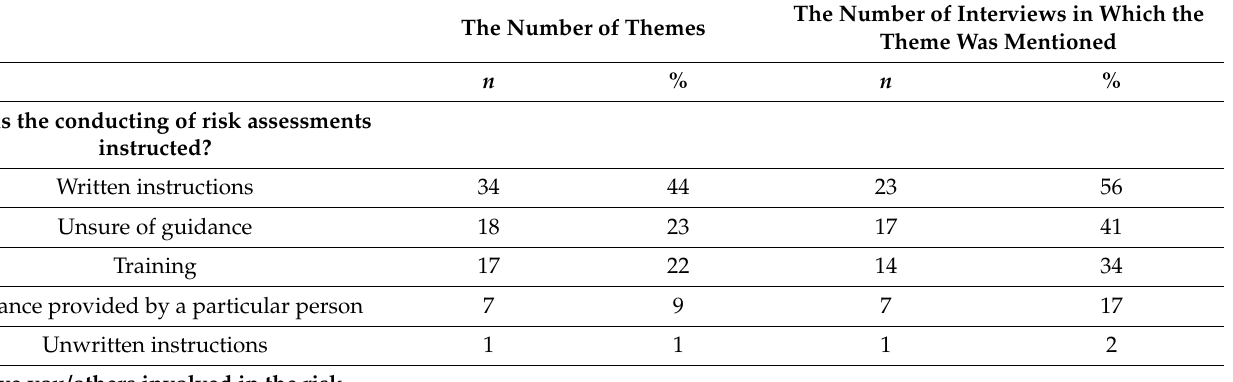
Table A1. The number and percentage of responses to the themes as well as the number and percentage of interviews in which the theme is